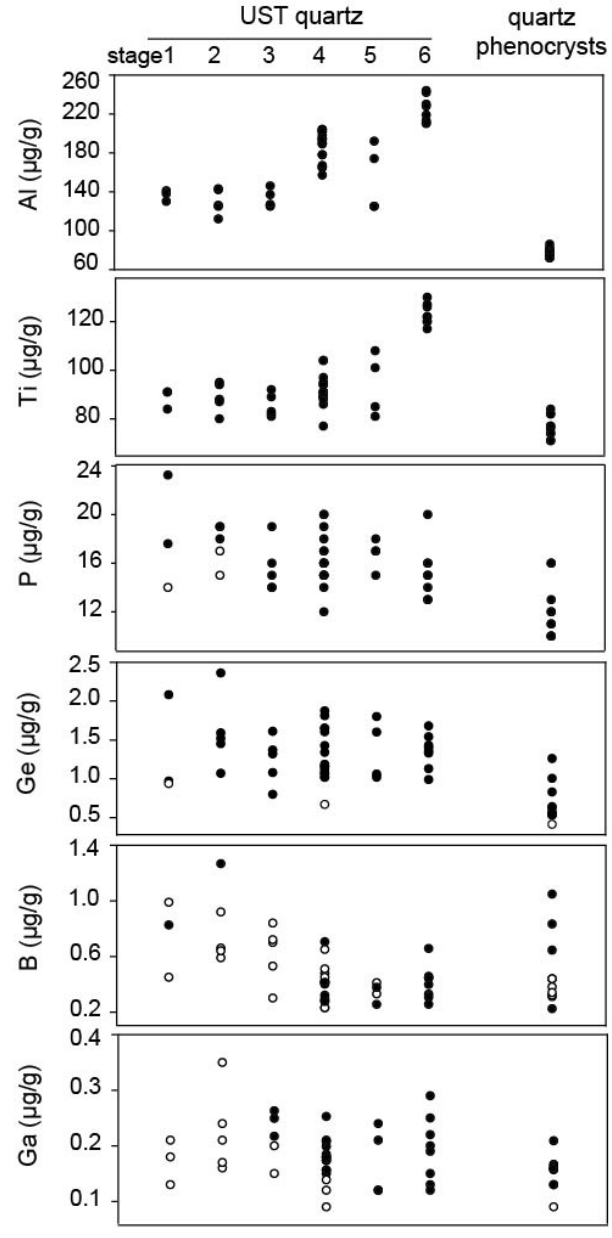
Figure 8. Trace element compositions in quartz in UST quartz stages and quartz phenocrysts. Empty symbols represent detection limits of LA-ICP-MS calculated by the protocols described by Longerich et al. (1996) [52] adopted in the SILLS program [45].